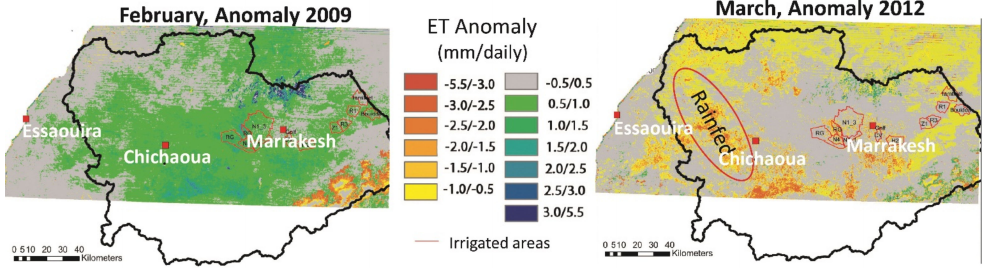
Figure 9. Monthly evapotranspiration anomalies with regard to the 2001–2015 climatology: ( a ) Febru- ary 2009; ( b ) March 2012. The main irrigated perimeters of the plain are overlaid for